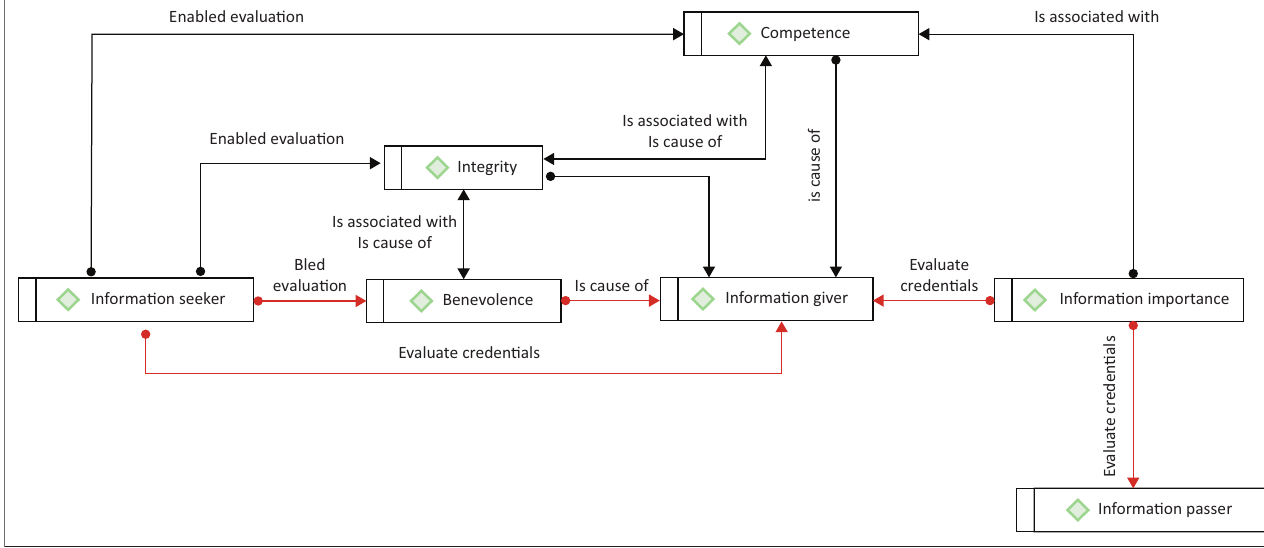
FIGURE 3: A network of health information exchange on social network